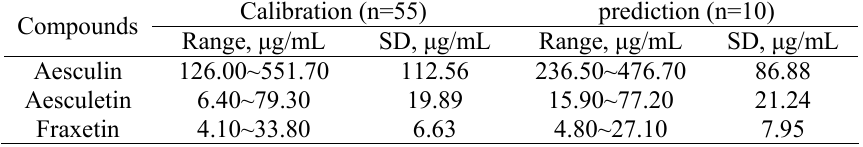
Figure 4. The squared mahalanobis distance values of samples and the ARC value (black line) Table 2. Calibration and prediction subset partitioning after